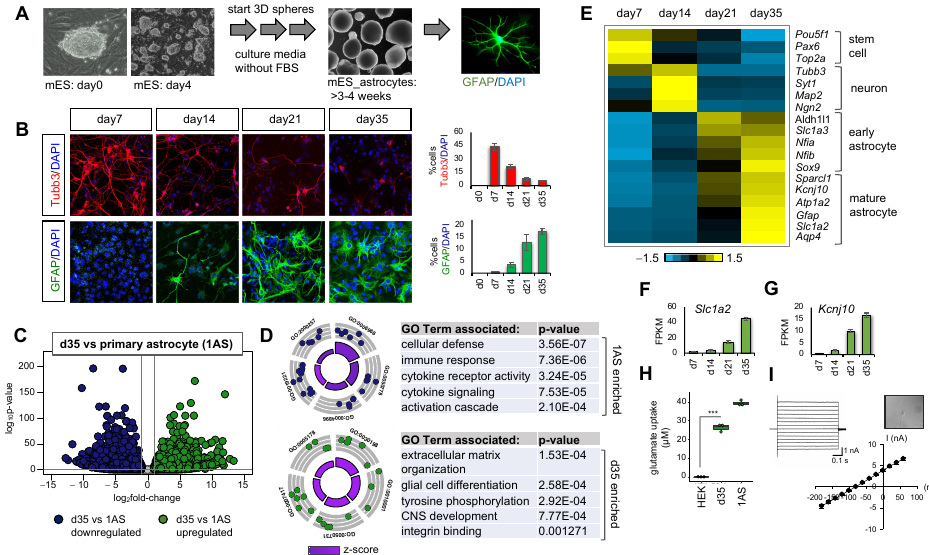
Figure 1. Generation of mouse embryonic stem cell derived astrocytes (mES_astrocytes) from 3D organoid-like spheres. ( A ) Schematic of culture protocol. ( B ) Analysis of Tubb3 and GFAP in mES_astrocyte culture from day 7 to day 35 ( n = 3 images per time point). ( C ) Volcano plot showing significance versus log 2 fold-change depicting RNA-Seq data comparing serum-containing primary culture (1AS) and day 35 mES_astrocyte transcriptome ( n = 3, p < 0.05, fold-change >2). ( D ) Gene Ontology (GO) circle plot and table showing top GO terms found in differentially expressed genes (DEGs; p < 0.01). ( E ) Heatmap showing stem cell and neuronal, early, and later mature astrocyte markers over time in culture. ( F ) Transcript expression of glutamate transporter ( Slc1a2 ) and ( G ) potassium channel ( Kcnj10 ) over time in mES_astrocytes. ( H ) Kinetics of cellular uptake of L-glutamate normalized to µ g protein ( n = 3 for each group, *** p < 0.001, one-way analysis of variance (ANOVA)) of day 35 mES_astrocytes. ( I ) Whole-cell patch clamp electrophysiology of day 35 mES_astrocytes ( n = 10 cells). Data are shown as the mean ±